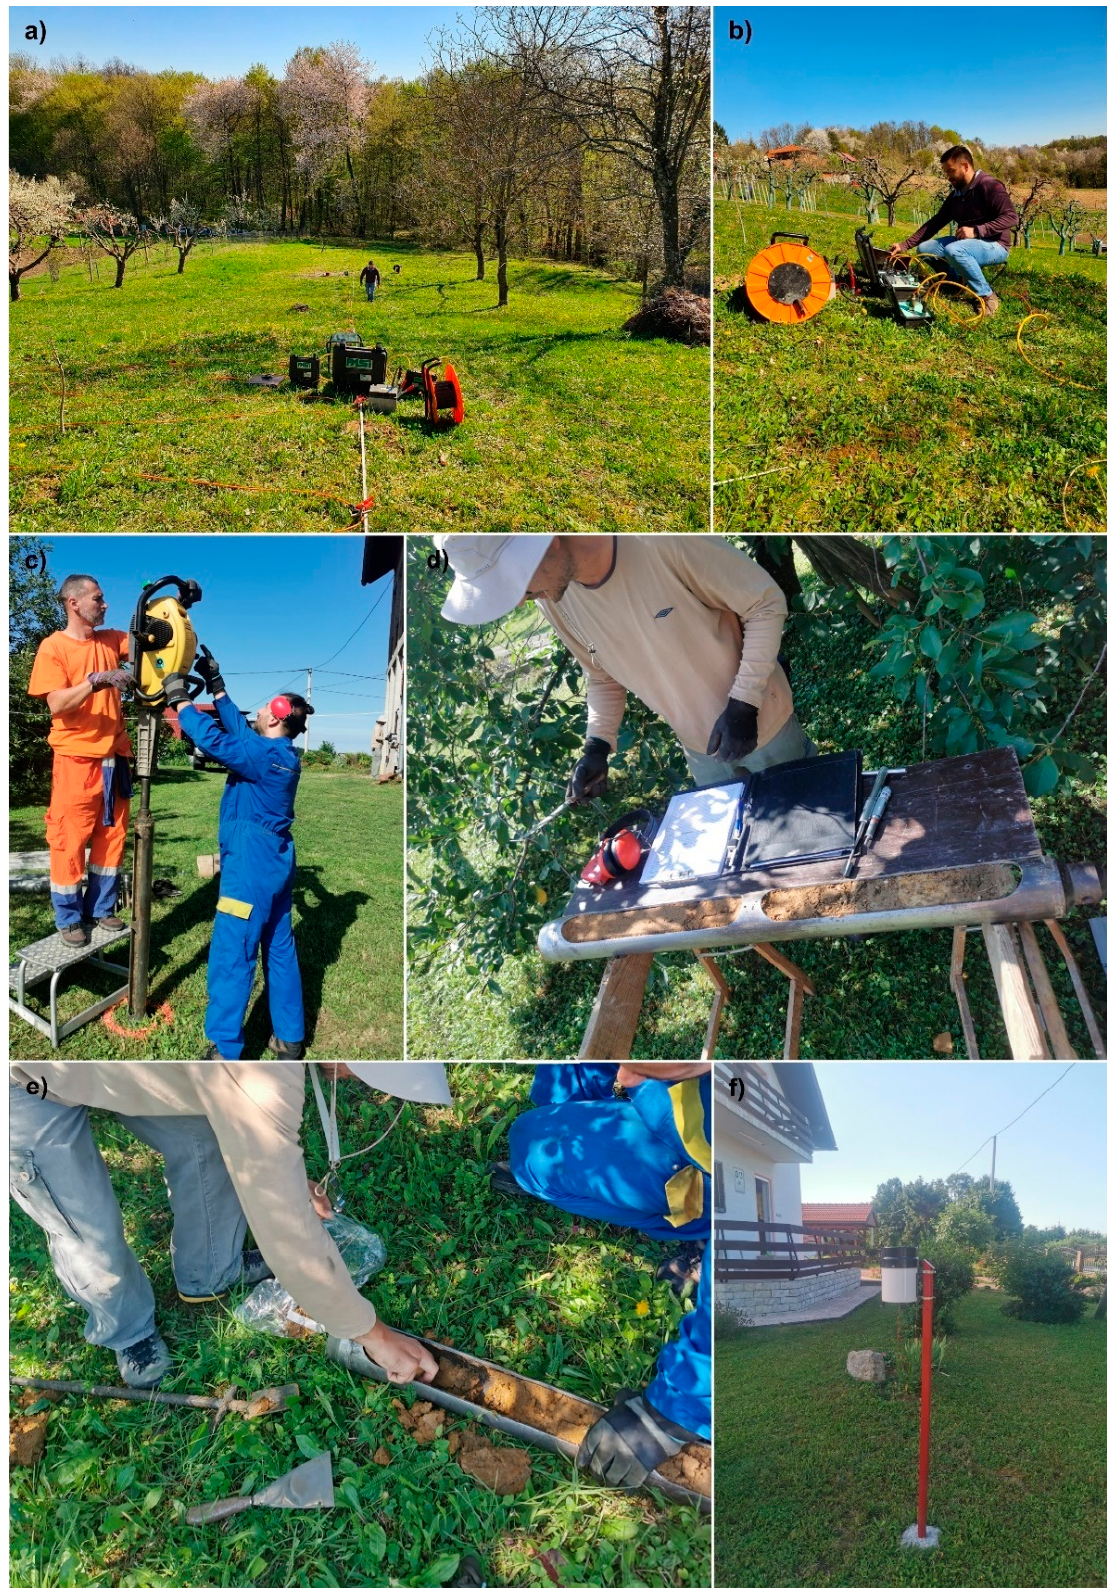
Figure 3. Overview of some field activities in Gajevo landslide area: ( a ) location of ERT3 cross-section outside landslide area; ( b ) measurement in progress on ERT3; ( c ) shallow borehole development; ( d ) borehole core determination; ( e ) borehole core sampling; ( f ) installed on-site pluviometer.